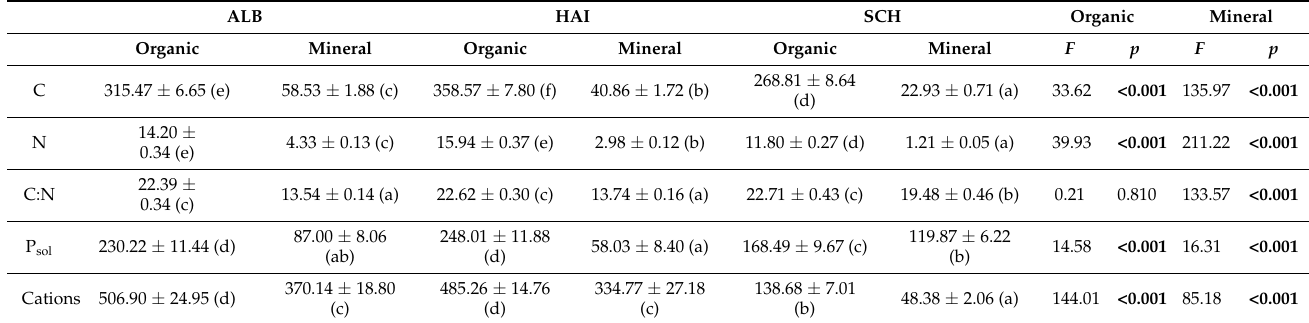
Table 2. Soil chemical properties in different soil layers and regions. ALB = Schwäbische Alb, HAI = Hainich-Dün, SCH = Schorfheide-Chorin. Carbon (C) (g kg − 1 DW); nitrogen (N) (g kg − 1 DW); ratio of CN; phosphorus (P sol ) (mg kg − 1 DW); Cations: sum of potassium (K), calcium (Ca) and magnesium (Mg) (mmol kg − 1 DW). Data indicate means ± SE ( n = 50). Linear models were used to compare the means of the element between the regions. Significant differences of the means are shown in bold. Pairwise differences of the nutrient elements between organic layer and mineral soil were compared using a post hoc test (HSD Tukey’s honestly significant difference). Different letters denote significant differences between soil layers and within the